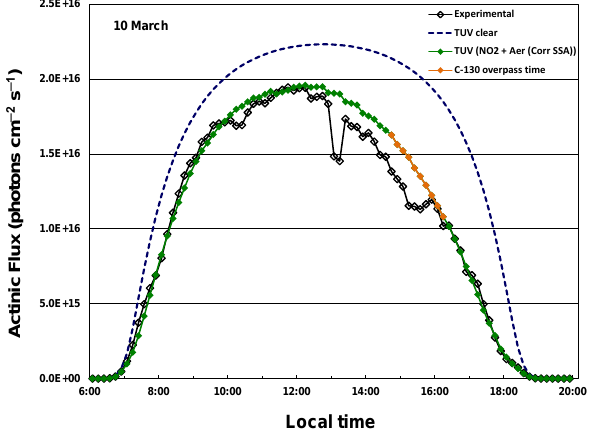
Fig. 5. Daily course of the actinic flux at surface for 10 March 2006. Measurements, calculations for clear sky, and calculations for pol- luted (NO 2 + aerosols (Corr SSA)) conditions. Orange diamonds show the period in which the C-130 aircraft flew over T1.